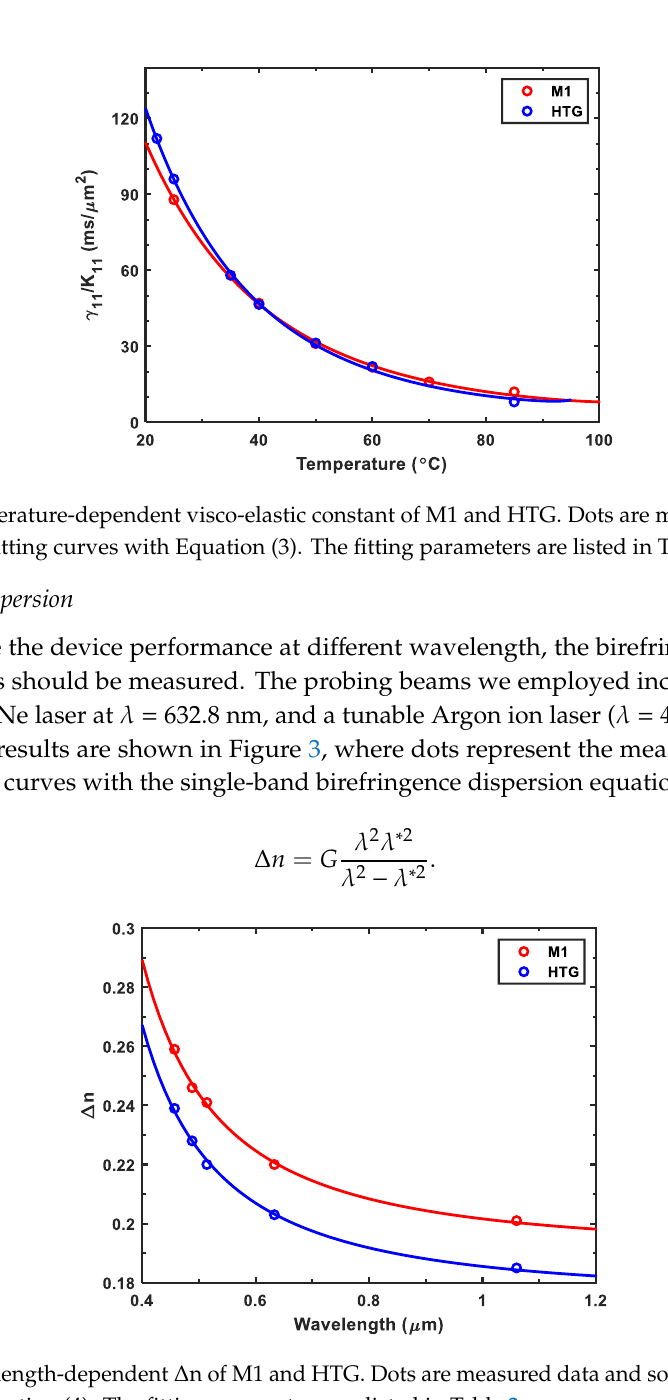
Table 2. Fitting parameters obtained through Equations (2)–(4).